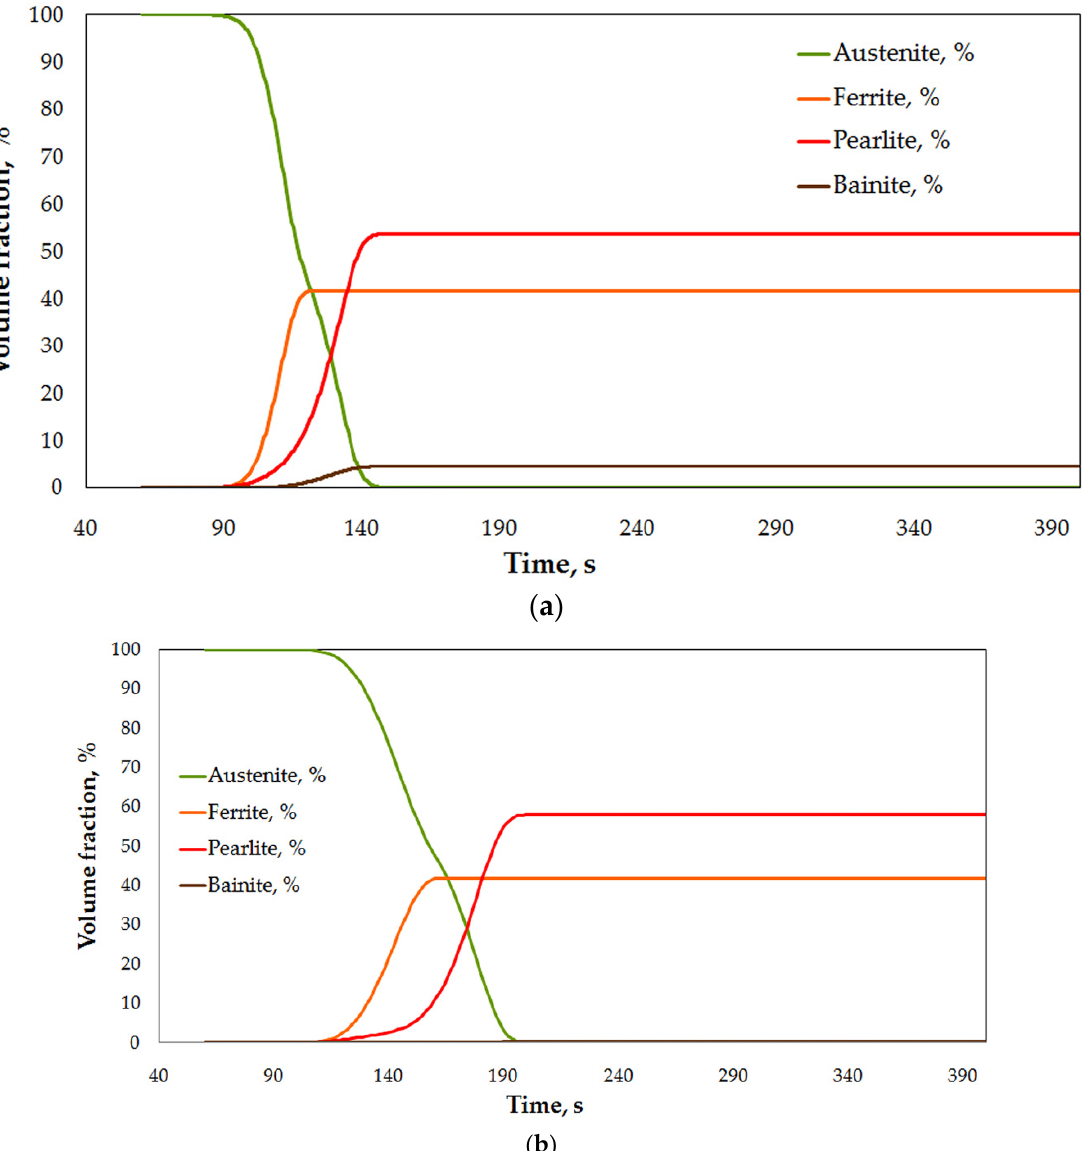
Figure 18. Numerically calculated volume fractions in locations: ( a ) T1 (spray), and ( b ) T3 (fan).